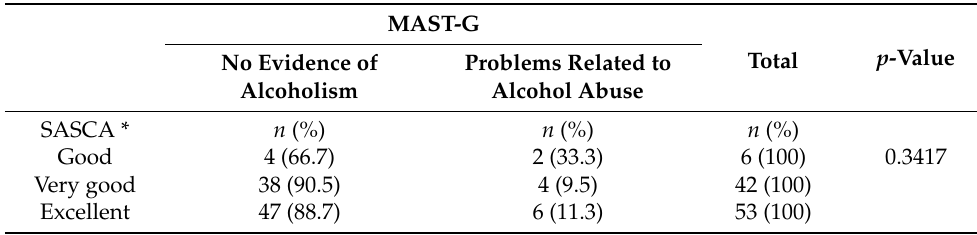
Table 4. Association of Michigan Alcoholism Screening Test-Geriatric Version (MAST-G) with the domains of self-care ability scale (SASCA) of elderly people enrolled at the Open University for Elderly People ( n = 101).